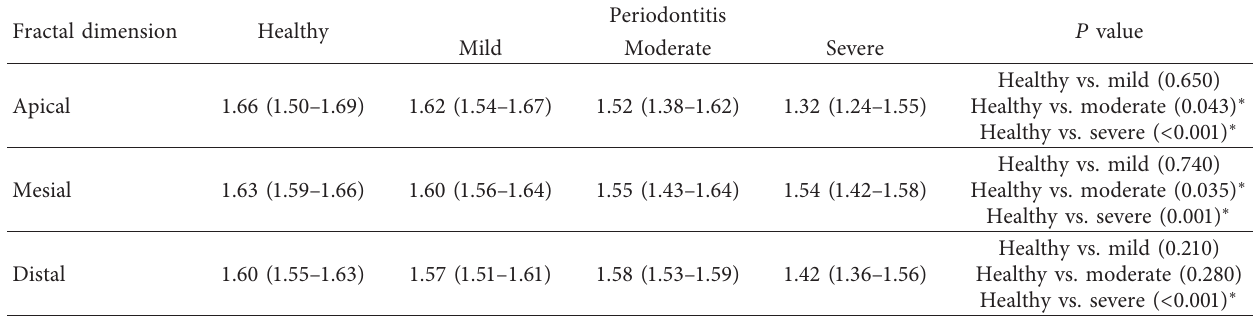
Table 2: Median (IQR) values of fractal dimension in different regions of interest in study groups. Fractal